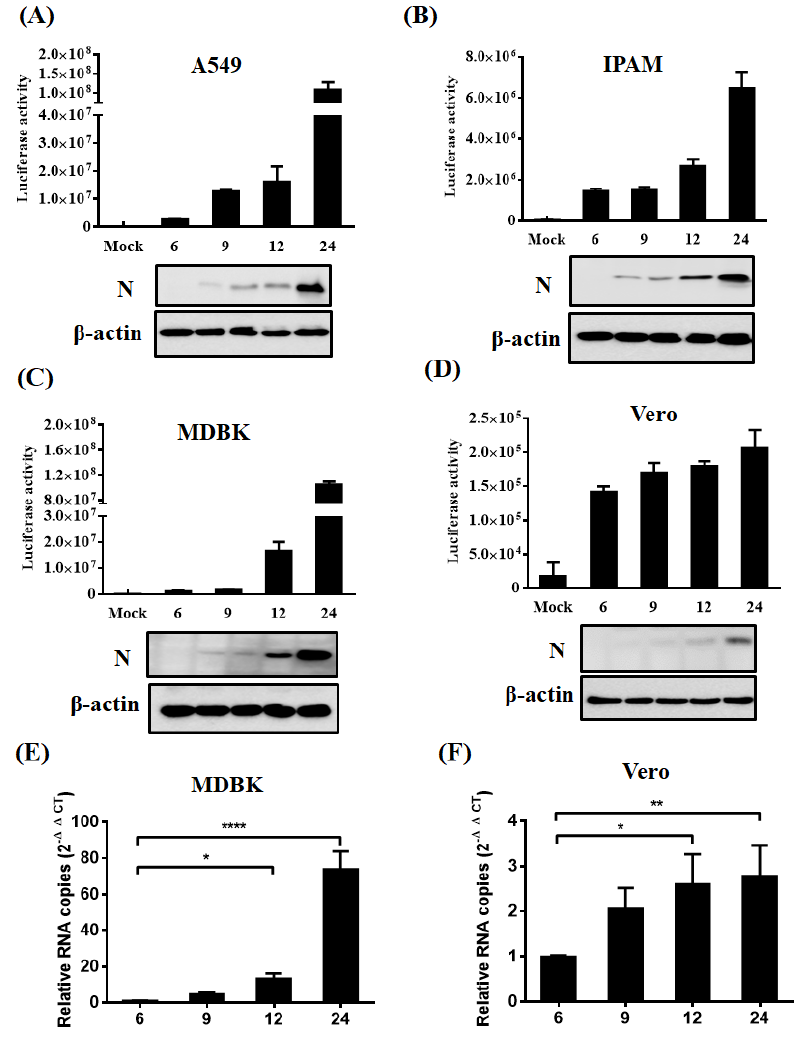
Figure 7. Identification of permissive cell lines. ( A – D ) Identification of permissive cell lines via luciferase activity assay and Western blot. A549 ( A ), IPAM ( B ), MDBK ( C ) and Vero ( D ) cells were infected with Nluc reporter virus in the presence of indicated concentration of trypsin. After 6, 9, 12, 24 hpi, cells were harvested and subjected to the measurement of luciferase activity and Western blot assay using antibodies against N and β -actin. ( E , F ) RT-qPCR assay for viral infection. MDBK ( E ) and Vero ( F ) cells were infected with Nluc reporter virus as described in panel A, followed by the detection of relative viral mRNA level by RT-qPCR at different time points post infection. * p < 0.05; ** p < 0.01; **** p <